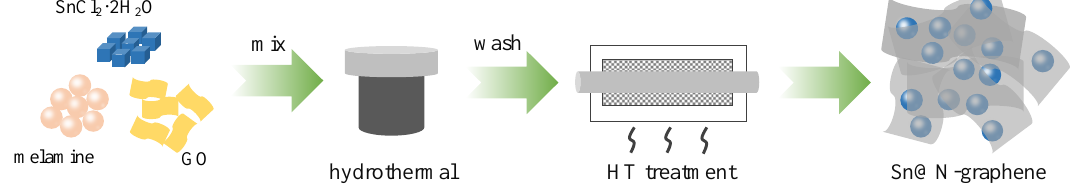
Figure 1. Schematic diagram of the synthesis of Sn@N-G composite. 106